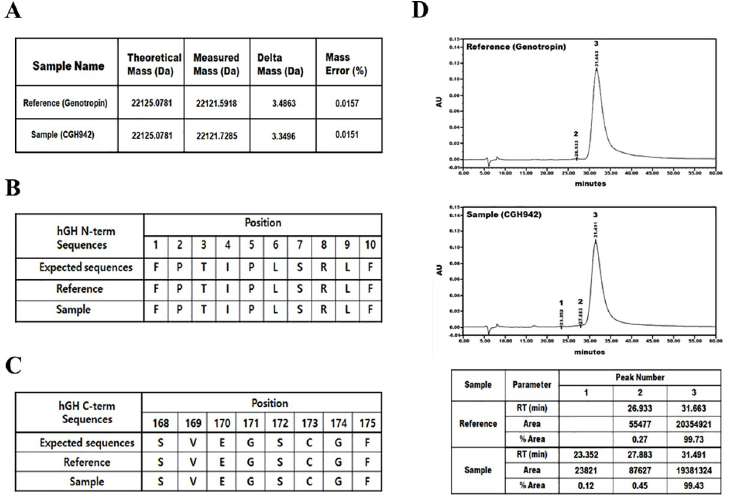
Fig 4. Structural characterization of CGH942. (A) Total mass, (B) N-terminal sequence, (C) C-terminal sequence, and (D) Reverse-phase-UPLC